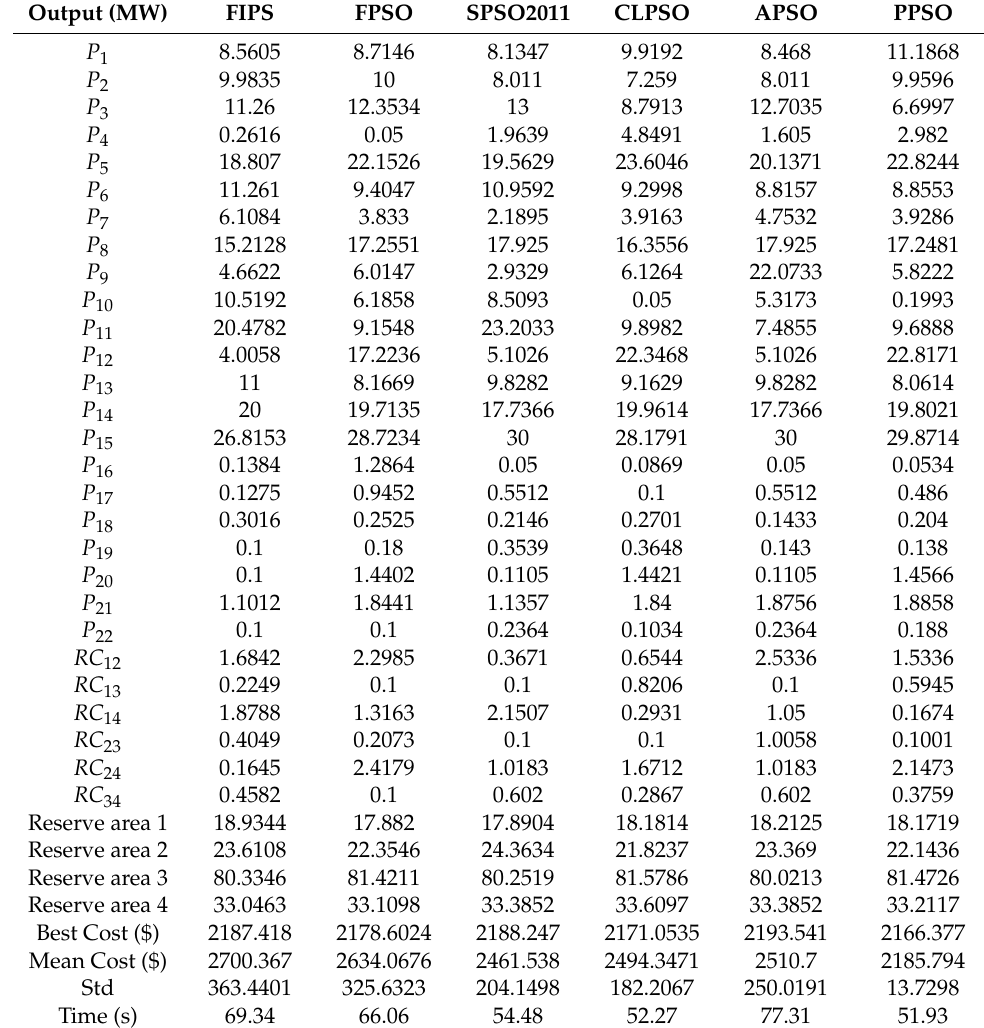
Table 5. Optimization results obtained by the PSO optimizers for the RCMAED problem for the four-area power